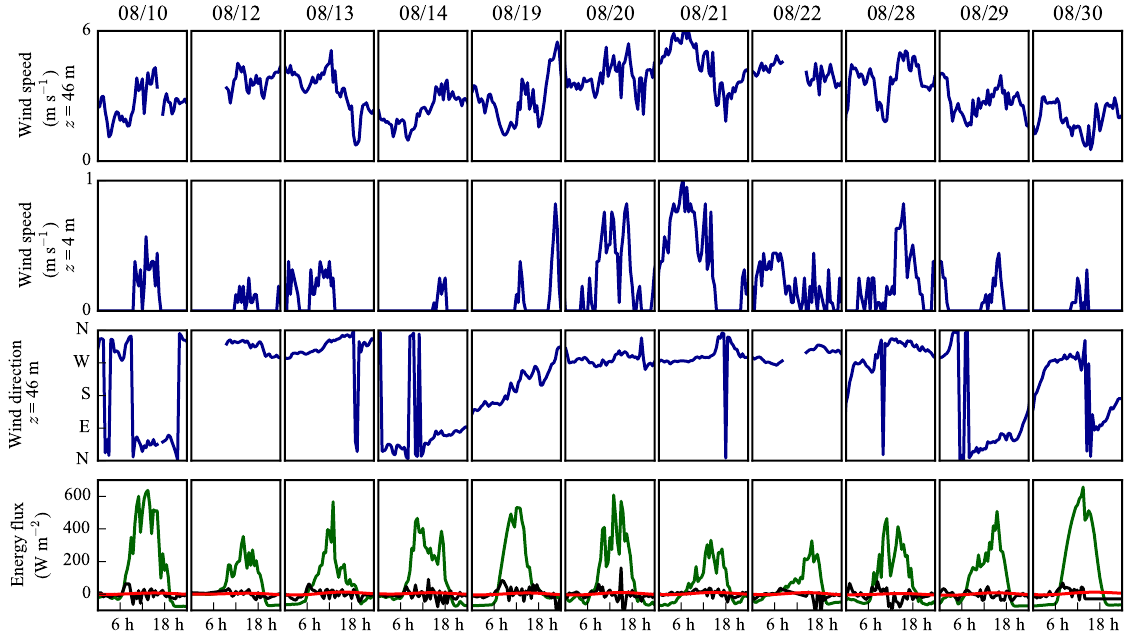
Figure 4. Meteorological conditions during the days that both DTS and EC data were available. From top to bottom: wind speed at the top of the tower, wind speed at the bottom of the tower, wind direction at the top of the tower, and the measured energy fluxes (green: net radiation; red: soil heat flux; black: energy storage change d Q d t